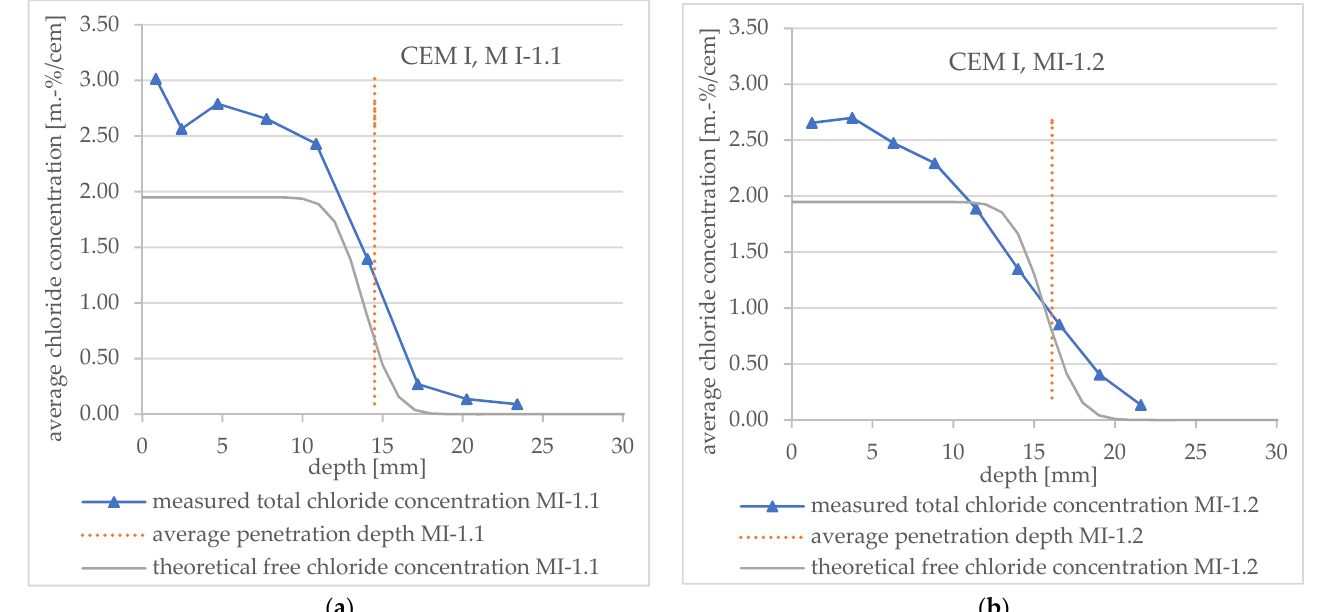
Figure 11. Total chloride concentration profiles measured after an RCM test including average penetration depth (vertical lines) measured after spraying AgNO 3 and theoretical profile ( a ) for CEM I mortar specimen no. MI-1.1 and ( b ) for CEM I mortar specimen no.